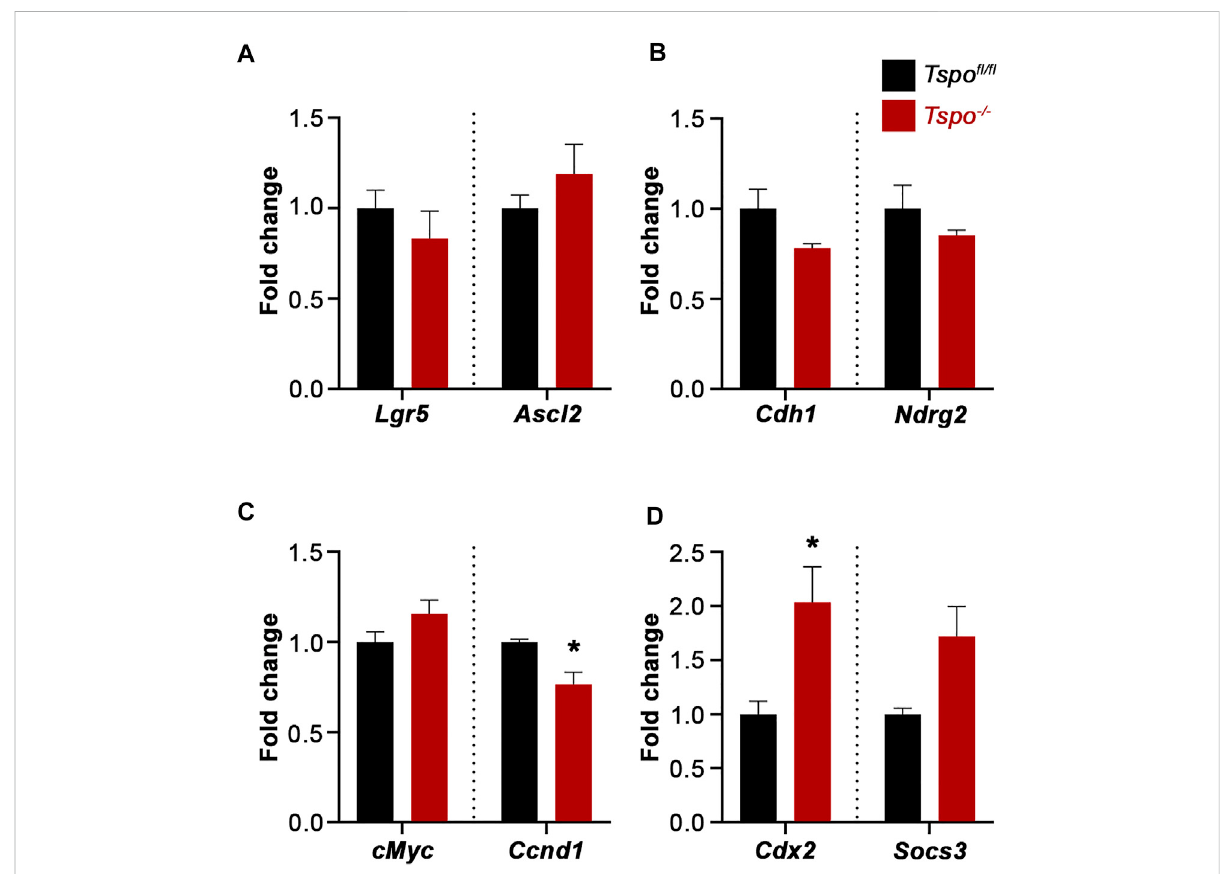
FIGURE 5 Baseline gene expression evaluating colonic epithelial functions in Tspo − / − mice. (A) Expression of Lgr5 and Ascl2 , indicative of intestinal stem cell identity, showed nodifferencebetween Tspo − / − and Tspo fl / fl colons. (B) Expression of Cdh1 and Ndrg2 ,indicative ofadhesion/epithelial integrity, showed no difference between Tspo − / − and Tspo fl / fl colons. (C) Expression of cMyc and Ccnd1 , Wnt targets indicative of proliferation showed divergent effects; cMyc showed no difference between Tspo − / − and Tspo fl / fl colons, whereas Ccnd1 was signi fi cantly downregulated in Tspo − / − colons ( p =0.0280). (D) Expression of Cdx2 , transcription factorassociated withintestinal epithelialdevelopment/identity,wassigni fi cantly higher in Tspo − / − colons compared to Tspo fl / fl colons ( p = 0.044). Expression of Socs3 , a regulator of cytokine signaling in in fl ammation, was higher on an average in Tspo − / − colons compared to Tspo fl / fl colons, but did not reach statistical signi fi cance ( p = 0.0625). Signi fi cance indicated as * p <